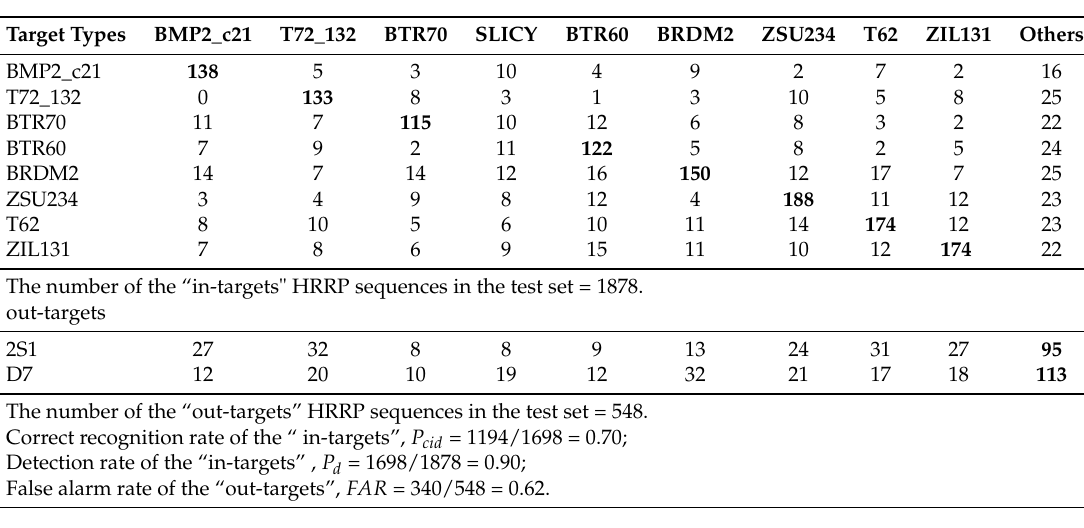
Table 2. Test results of the SSDM model trained in time-frequency domain with 0.75 ◦